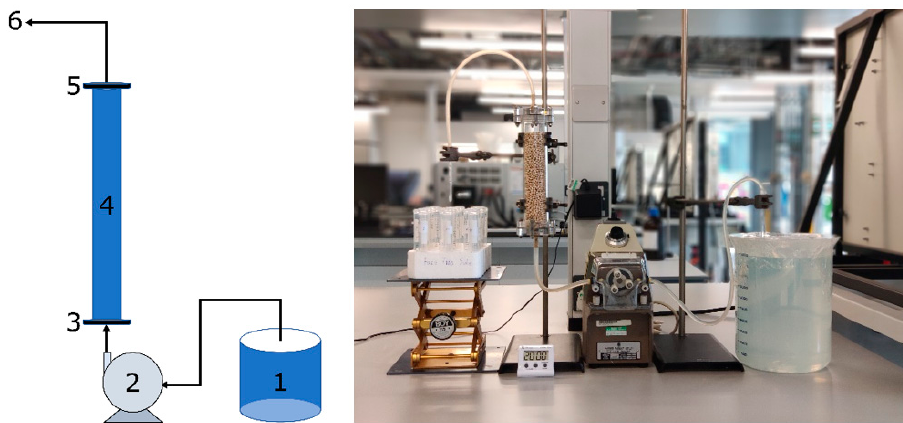
Figure 1. The fixed-bed reactor: (1) represents the heavy metal solution feed tank, then the solution is pumped up through the peristaltic pump (2) to the plexiglass column (4) equipped with a plastic sieve (3 and 5) at the bottom and the top which is stuffed with zeolites and sent out (6). The optical graph is also presented on the